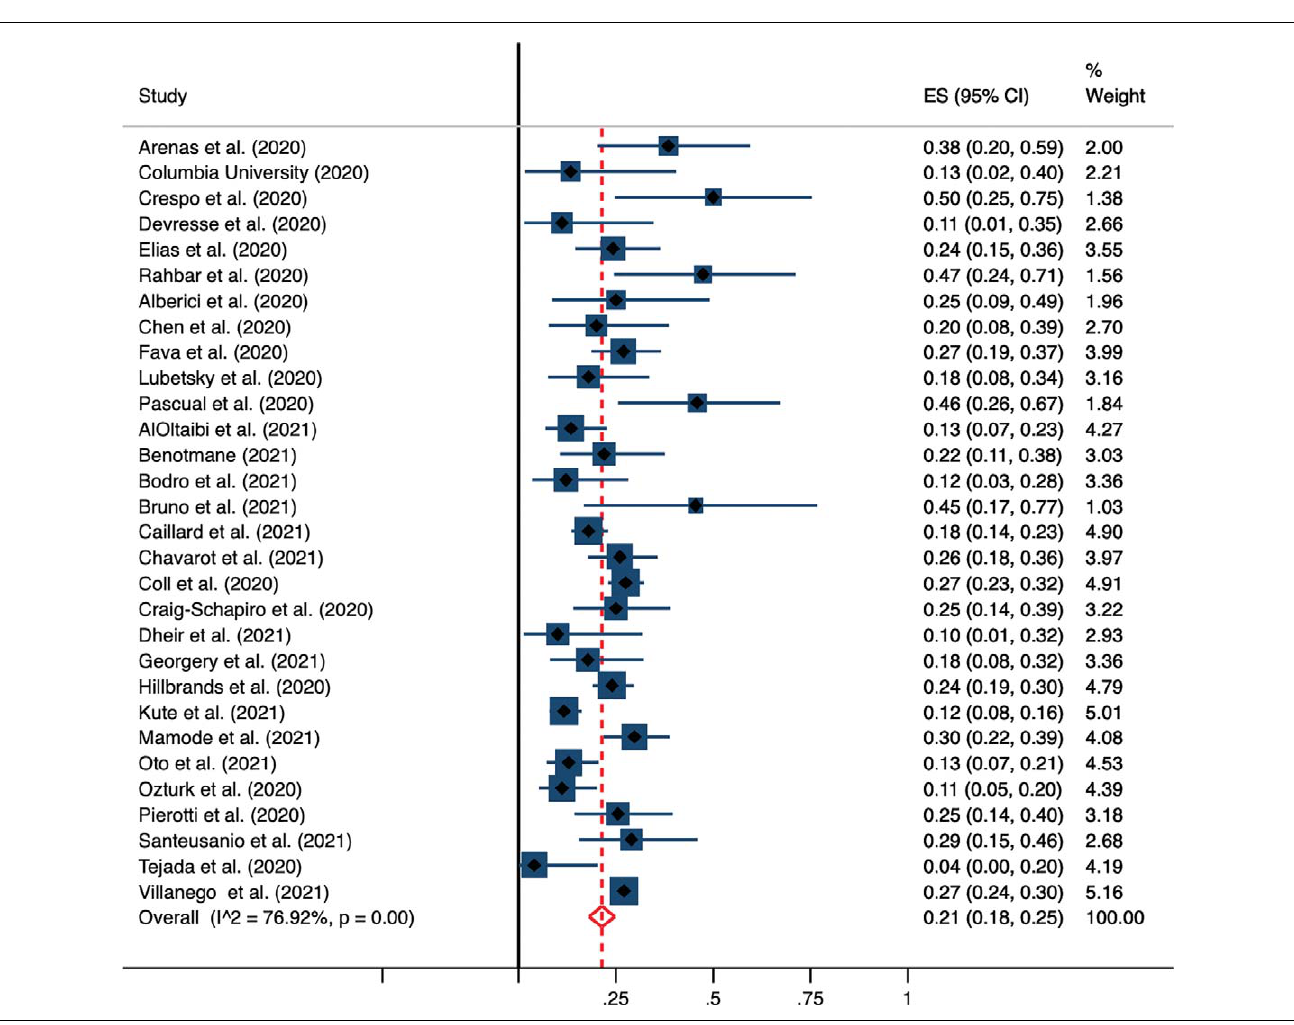
Figure 2. Pooled estimate on mortality rate of kidney transplant recipients with COVID-19